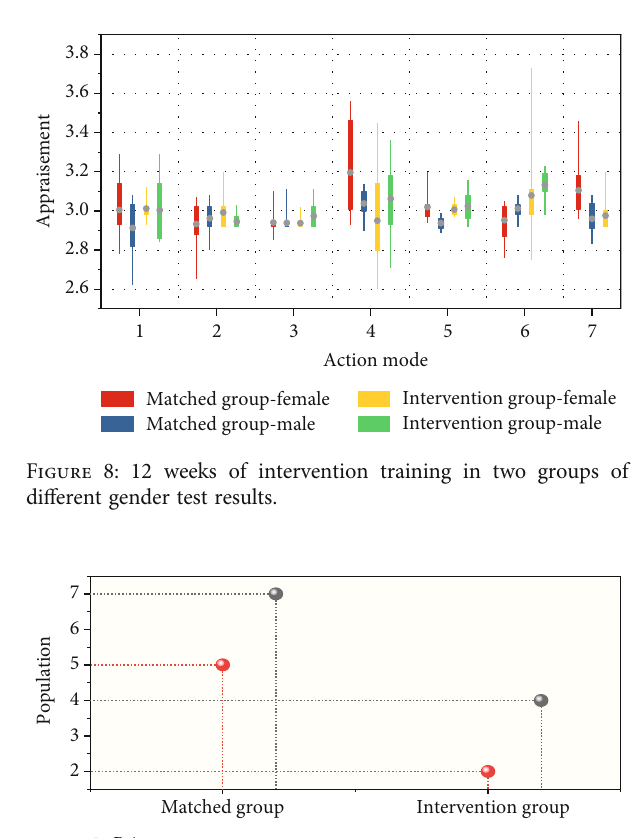
Figure 7: Assessment results of di ff erent genders before rehabilitation.